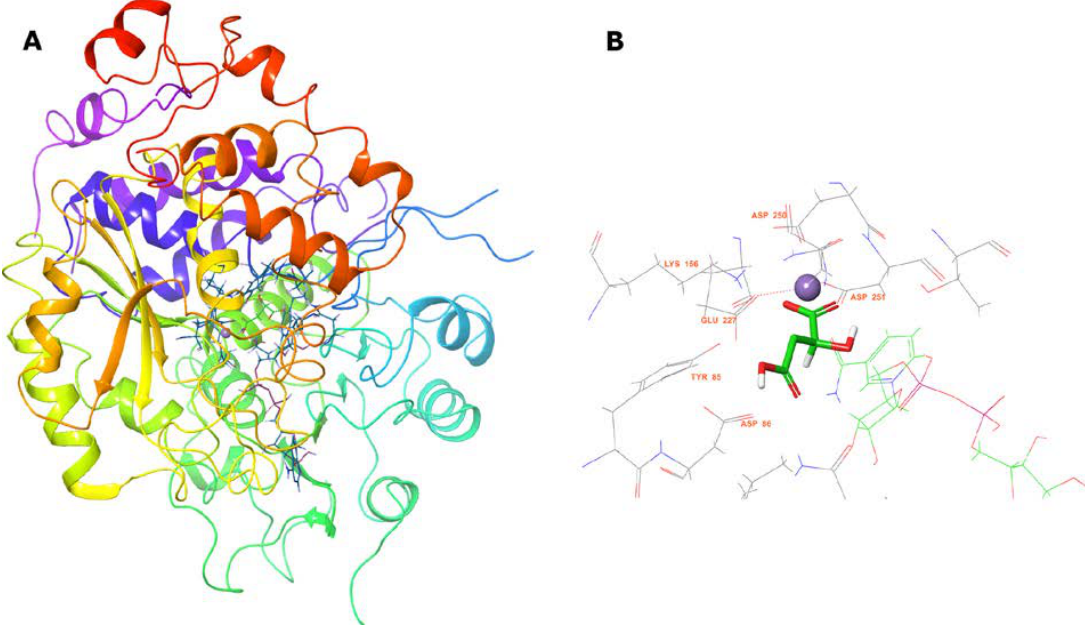
Figure 7. Homology model of Oenoccocus oeni MLE. ( A ) Protein structure after 200 ns MD simulation. ( B ) MAL pose inside predicted MLE binding site.